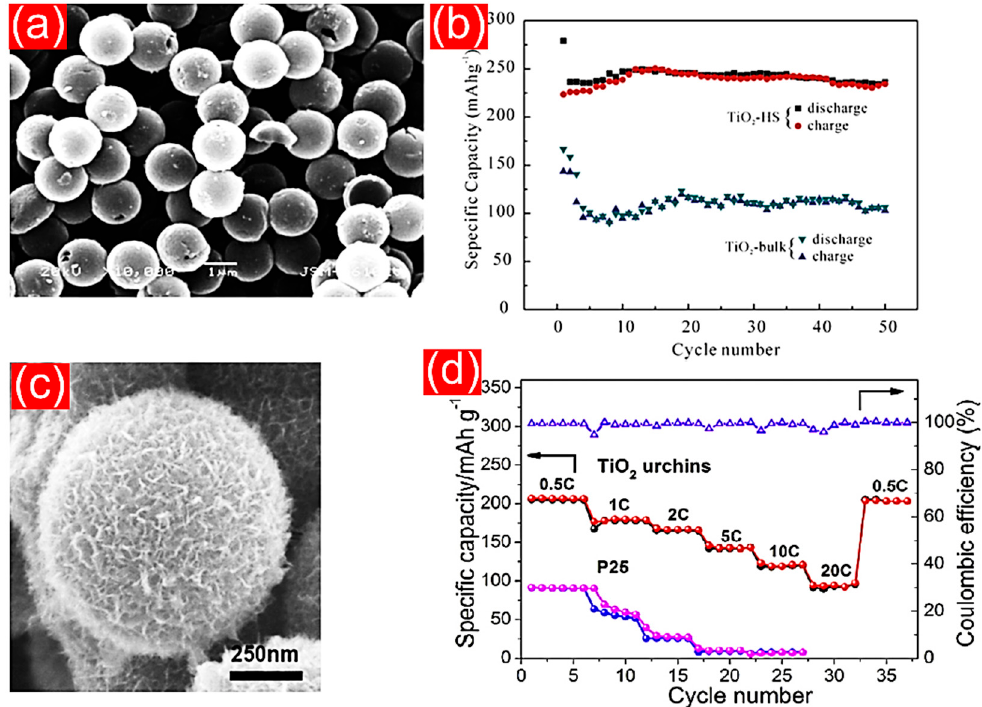
Figure 7. ( a ) SEM micrograph and ( b ) galvanostatic cycling of TiO 2 hollow spheres (HS) in comparison with bulk TiO 2 at 0.1 C adapted with permission from ref. [105]. ( c ) SEM image and ( d ) rate capability of the porous TiO 2 urchins compared to commercial P25 nanoparticles adapted with permission from ref. [114].